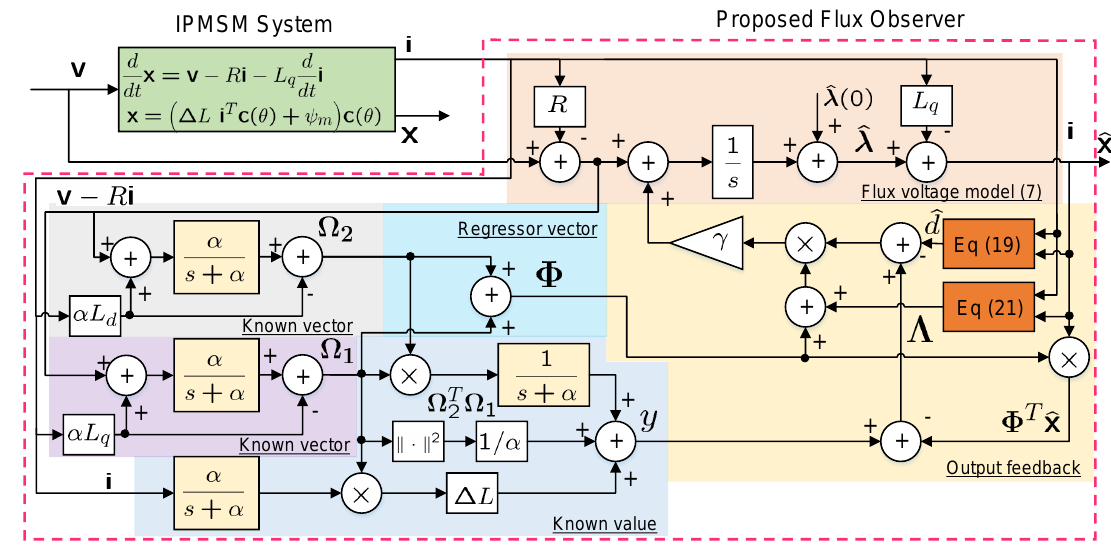
Figure 1. Proposed nonlinear observer based on linear regression